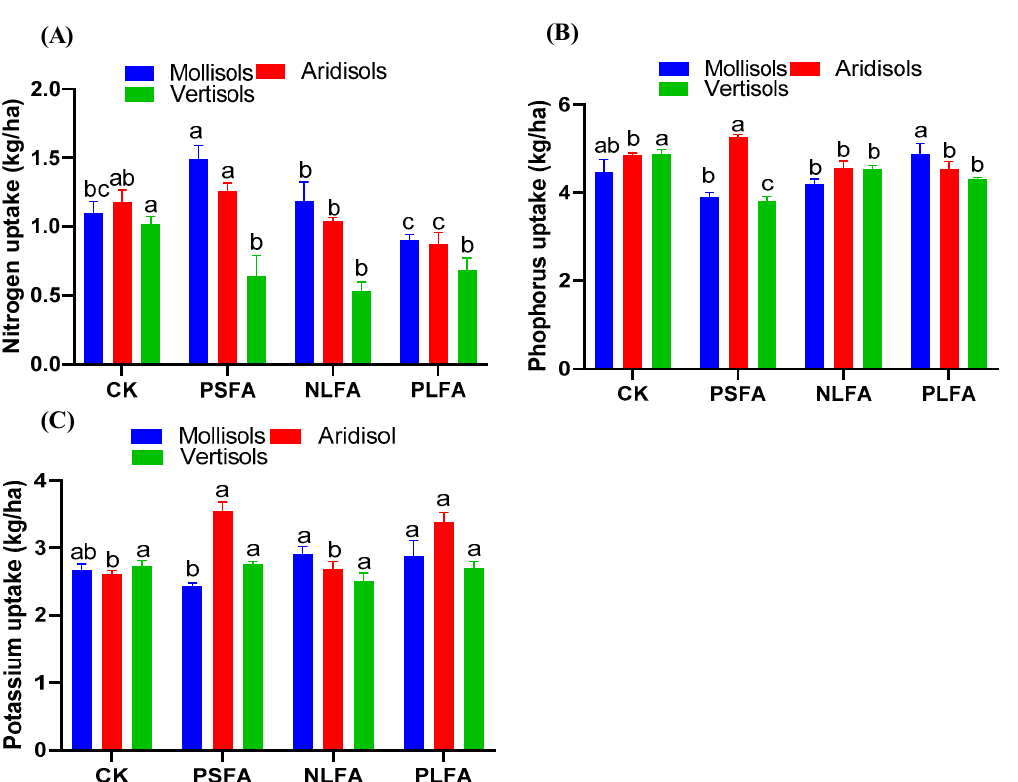
Figure 4. The effect of plant-derived solid fulvic acid (PSFA), mineral-derived liquid fulvic acid (NLFA), and plant-derived liquid fulvic acid (PLFA) on ( A ) nitrogen, ( B ) phosphorus and ( C ) potassium uptake of wheat grown in Mollisols, Aridisols, and Vertisols soils. The means ± standard errors are shown ( n = 4). Different letters (a, b, and c) indicate significant differences between the initial and final values of the soils based on a least significant difference test at a 5% significance level.